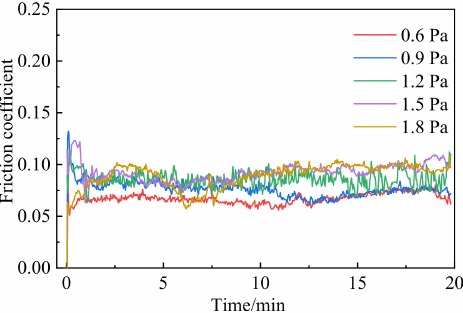
Figure 6. Friction coefficient curves at different deposition pressure. Three-dimensional morphology reconstruction of wear tracks is shown in Figure 7.